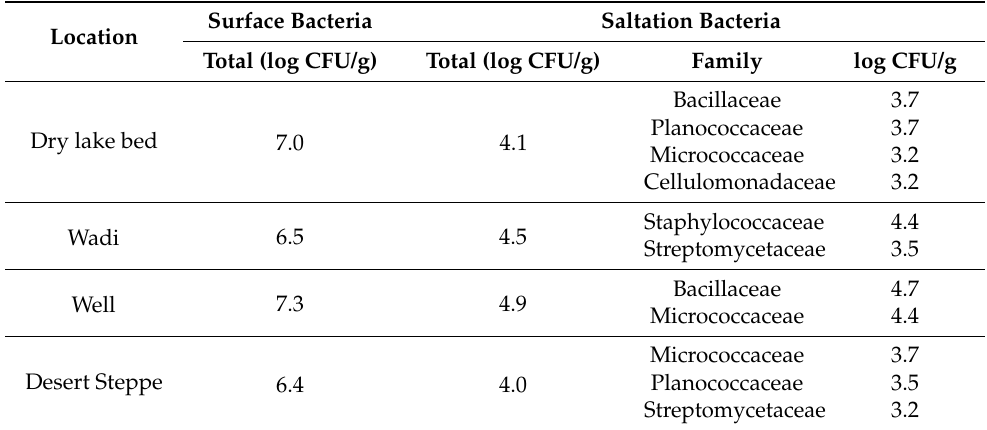
Table 2. Comparison between the number of bacteria on the ground surface and saltation bacteria.